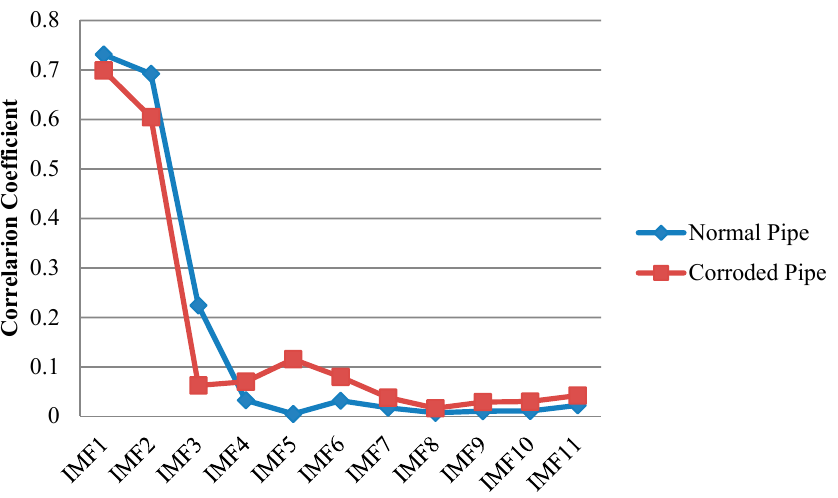
Figure 14. Absolute cross correlation of guided wave signals from pipes with their corresponding IMFs obtained from EEMD.